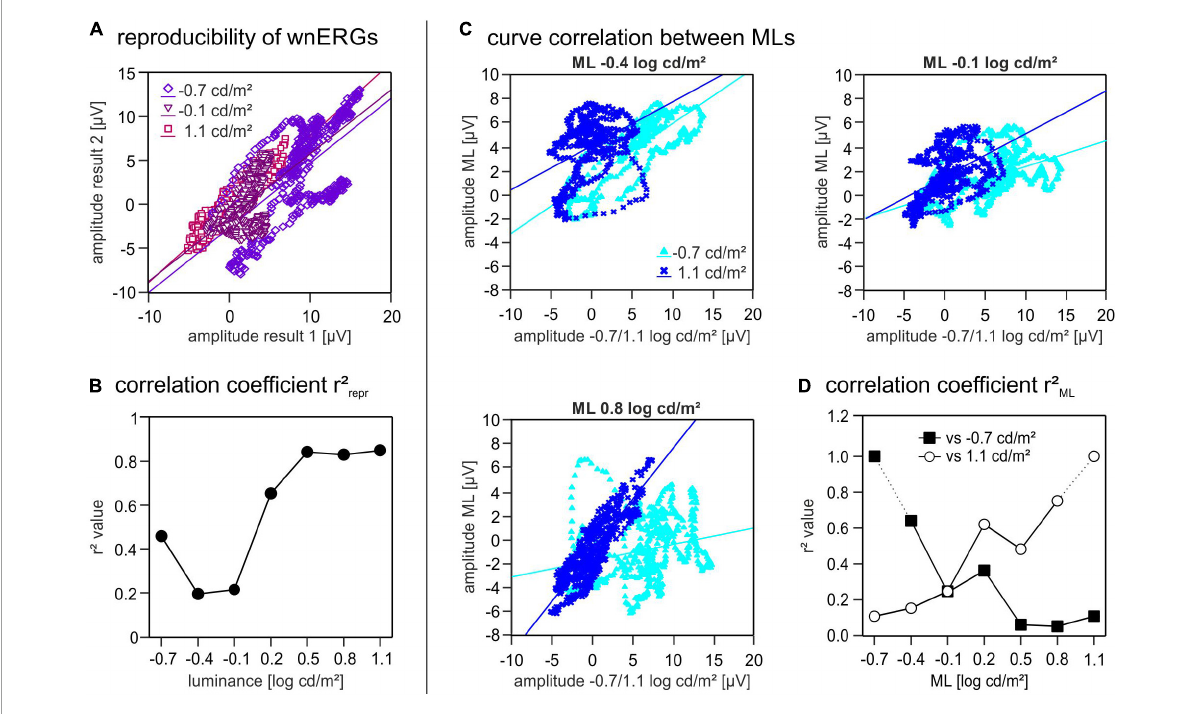
FIGURE4 Correlation coefficients. (A) Two repeated white noise electroretinogram (wnERG) recordings at one ML are plotted against each other [for three different mean luminances (MLs)]. Amplitudes of the first recording are shown on the abscissa and amplitudes of the second recordings are shown on the ordinate. Linear regression lines were fitted through all data sets. (B) r 2 repr values are plotted as a function of ML. (C) First and second wnERG recordings were further averaged at each ML. To study curve correlation between different MLs the wnERGs at all MLs were plotted against those obtained at –0.7 and at 1.1 log cd/m 2 on the X -axis. Potentials obtained at three different ML (–0.4, –0.1, and 0.8 log cd/m 2 ) are shown on the Y -axis. Linear regression lines were fitted through all data sets. (D) Linear regression of C gave two correlation coefficients r 2 ML for each ML (filled squares when plotted against –0.7 log cd/m 2 , open circles when plotted against 1.1 log cd/m 2 ).